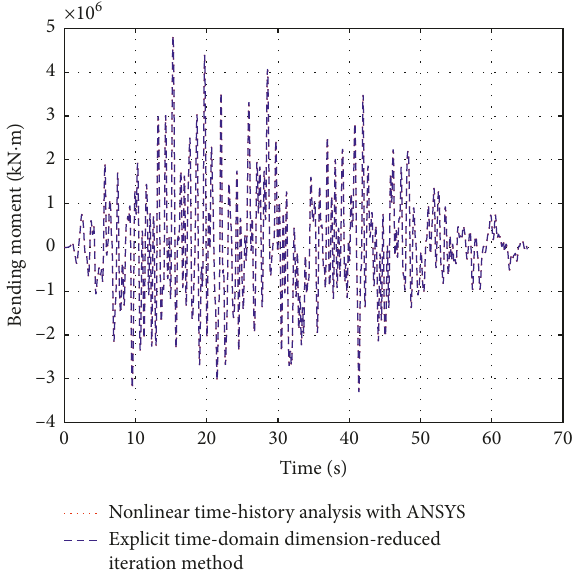
Figure 9: Longitudinal bending moment at the bottom section of the main